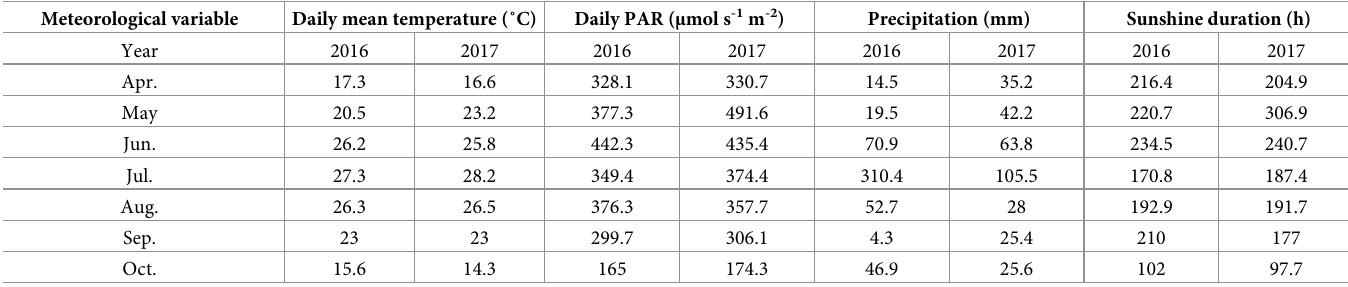
Table 2. Weather information during the cotton growing seasons in 2016 and 2017. Meteorological